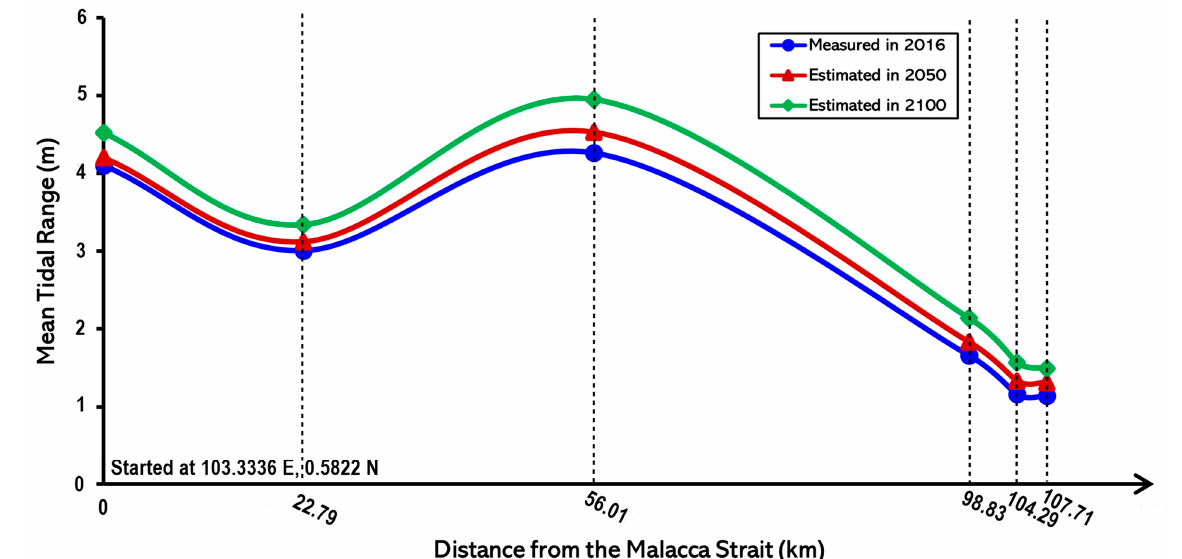
Figure 6. Estimated tidal range amplification in the estuary of Kampar as a response to sea level trends in the equatorial Malacca Strait.